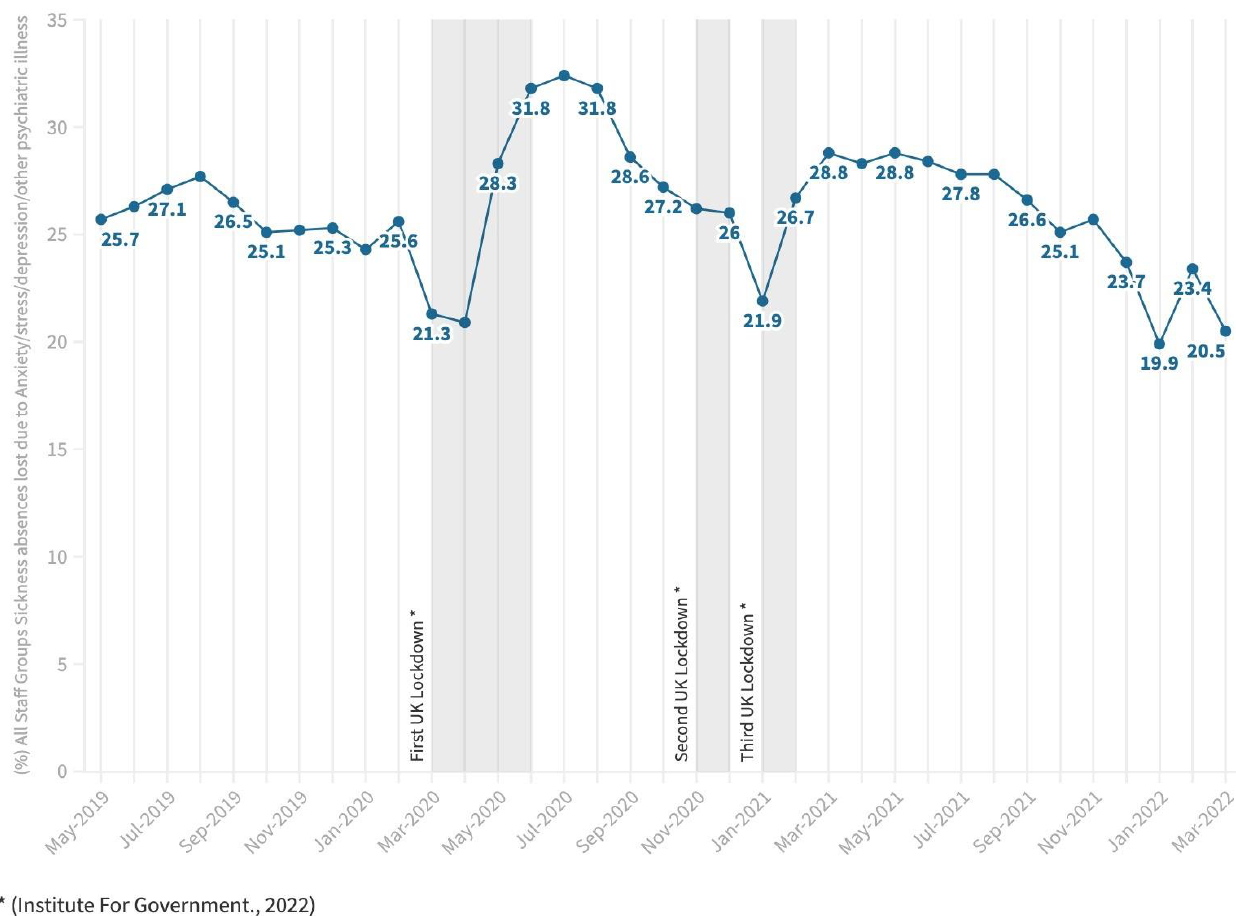
Figure 1. All staff groups sickness absence as a percentage of Full-Time-Equivalent (FTE) days lost due to anxiety/stress/depression/other psychiatric illnesses [1,6].